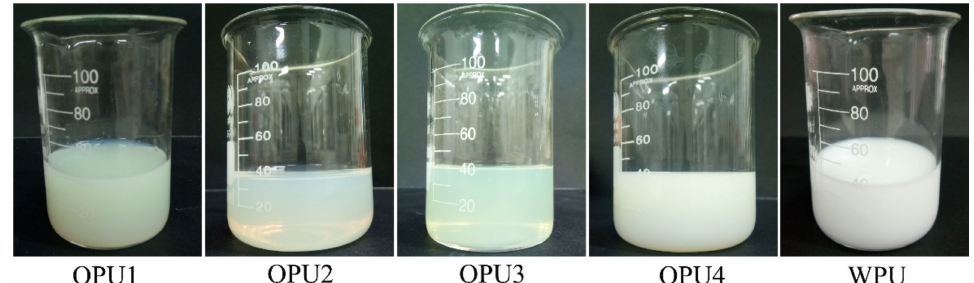
Figure 7. Images of OPU